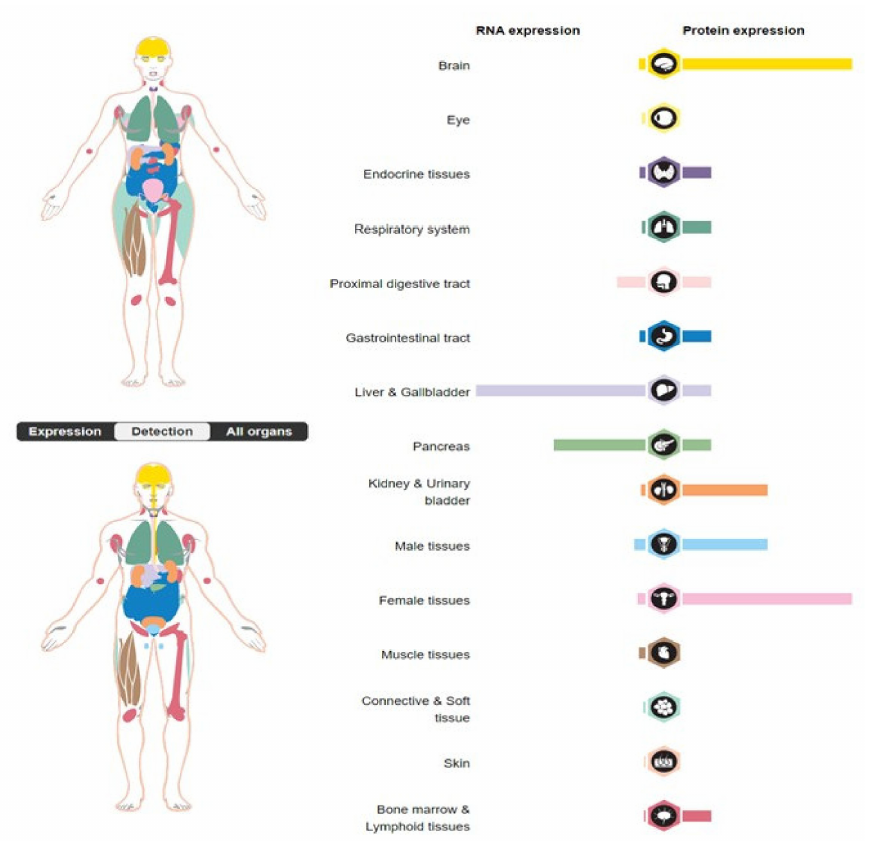
Figure 2. Tissue expression of the SERPINA3 gene (https://www.proteinatlas.org/ENSG000001961 36-SERPINA3/tissue; accessed on 17 December